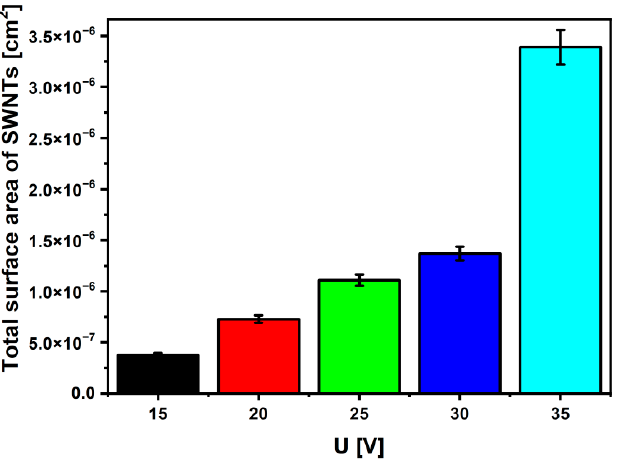
Figure 7. The total surface area (A total ) of SWNTs on the Ti-13Zr-13Nb alloy surface obtained by anodizing in 1 M C 2 H 6 O 2 + 4 wt% NH 4 F electrolyte at U of 15–35 V for 120 min.